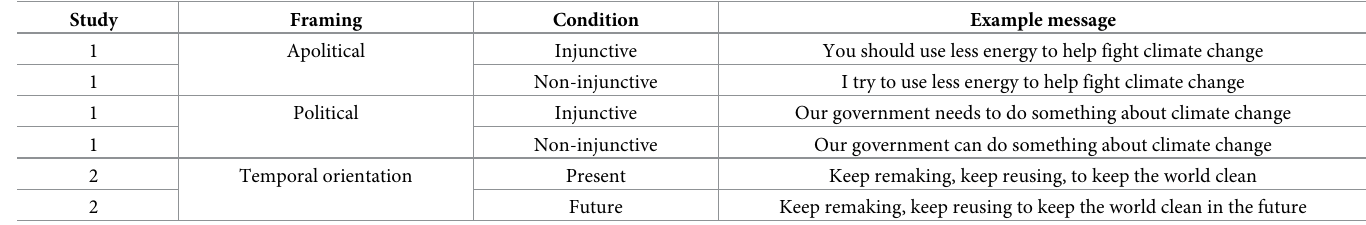
Table 1. Examples of messages in treatment groups for Studies 1 and 2 a